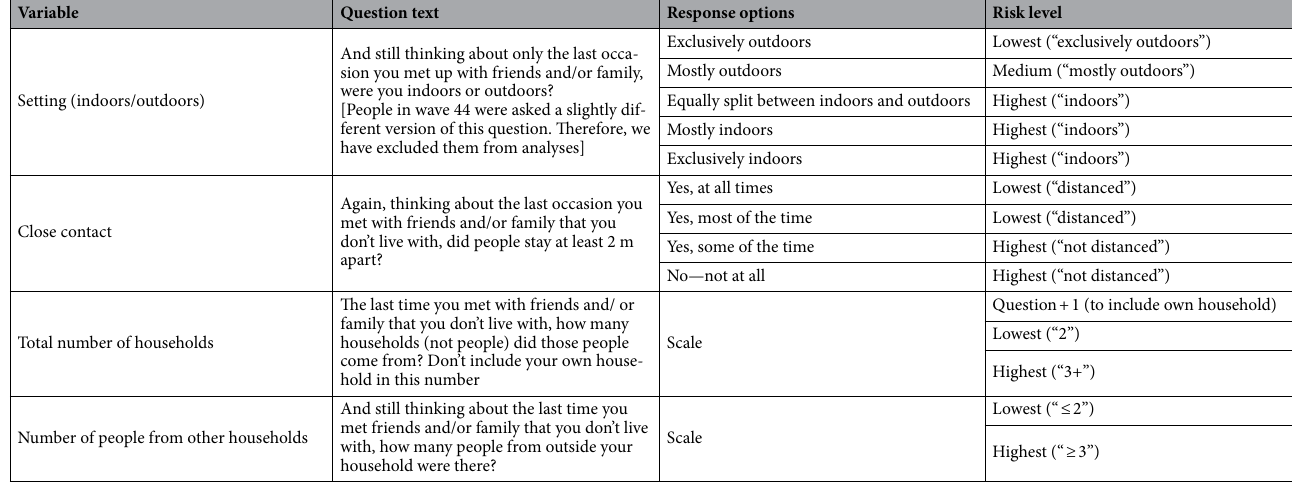
Table 2. Coding of variables to compute risky social mixing variable.